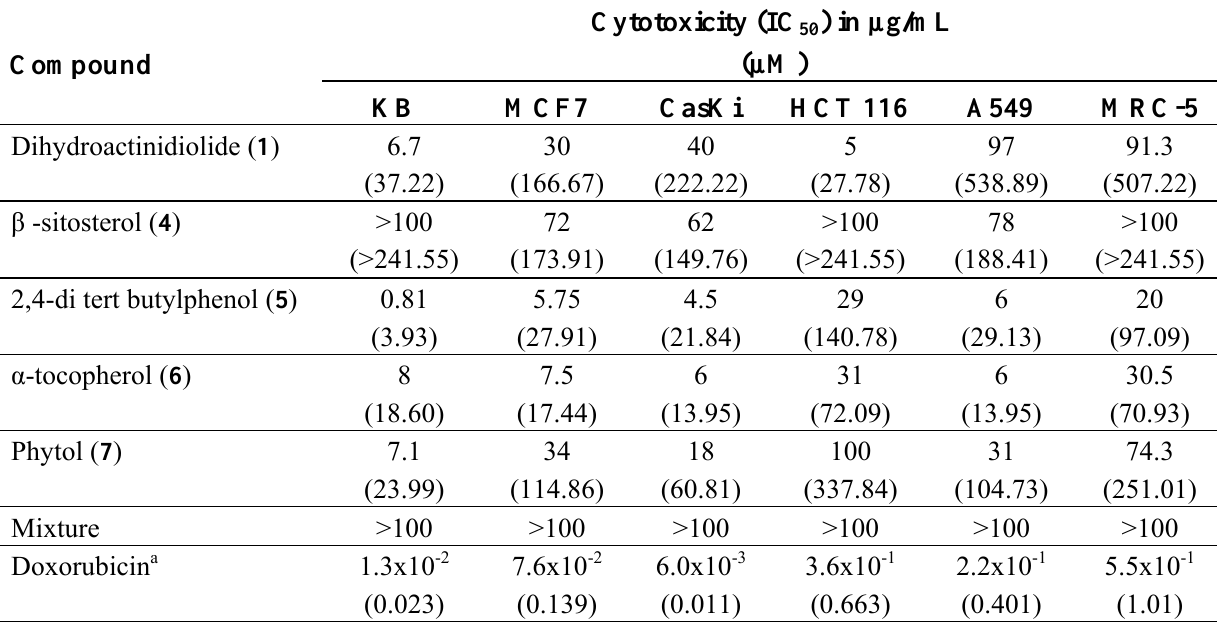
Table 1. Cytotoxic activity (IC values) of compounds 1 - 5 and mixture of sterols against 50 KB, CasKi, HCT 116, MCF7, A549 and MRC5 cell